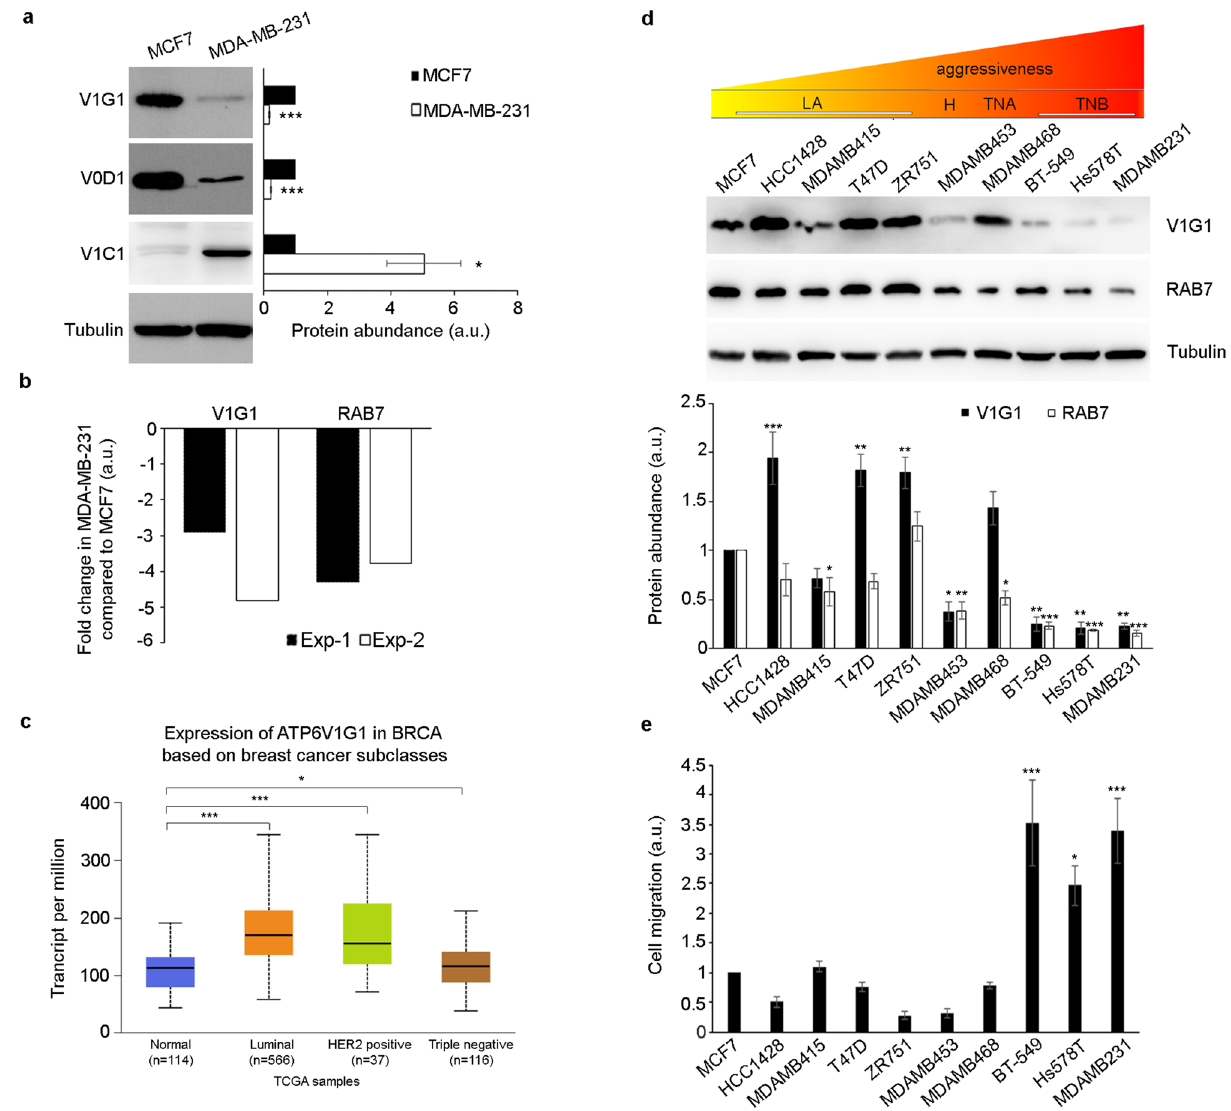
Figure 1. ATP6V1G1 gene expression in breast cancer cell lines. ( a ) Lysates of MCF7 and MDA-MB-231 cells analyzed by Western blot using specific anti-V1G1, anti-V0D1, anti-V1C1 and anti-tubulin antibodies. Data represent the mean ± s.e.m. of at least three experiments and statistical analysis was performed using Student’s t-test with MCF7 as referring sample. * = p < 0.05; *** = p < 0.001. ( b ) The amount of ATP6V1G1 and RAB7 transcripts was quantified, compared to the GAPDH transcript as control, using real-time PCR. The results of two independent experiments are shown (Exp-1 and Exp-2). ( c ) V1G1 expression data from the UALCAN database in breast cancer subclasses compared to normal breast tissues. * p ≤ 0.05; *** p ≤ 0.001. ( d ) Lysates of the indicated breast cancer cell lines, belonging to LA (luminal A), H (HER2 positive), TNA (triple negative A) and TNB (triple negative B) groups, were analyzed by Western blot using specific anti-V1G1, anti-RAB7, and anti-tubulin antibodies. ( e ) Wound healing assay of different breast cancer cell lines. Cells were imaged at the initial time point (T0) and 24 h after the scratch. Cell migration was measured as the ratio between closed area of the wound in MCF7 cells (referring sample set to 1) and each cell line. Data in panels d and e represent the mean ± s.e.m of at least three experiments and statistical analysis was performed using one-way ANOVA followed by Dunnett’s multiple comparisons test with control (MCF7 cells) as referring sample set to 1 (a.u. arbitrary unit). * p ≤ 0.05, ** p ≤ 0.01, *** p ≤